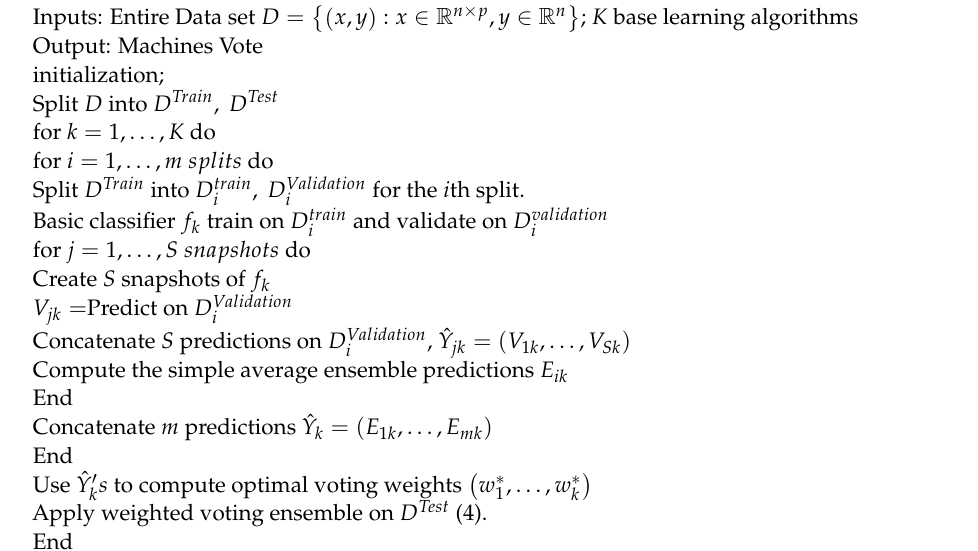
Algorithm 1. Machine weighted voting